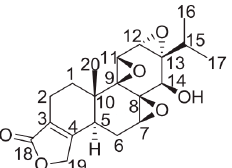
Figure 2. Schematic illustration of TP properties in the treatment of rheumatoid arthritis (RA). The